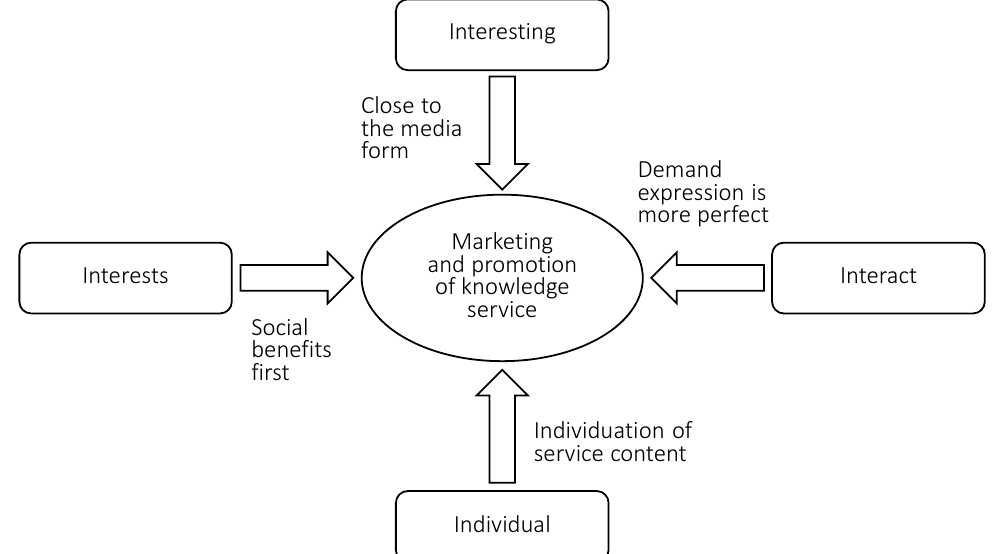
Figure 1. The influence of 4I principle on the marketing of knowledge services in university library from the perspective of micro